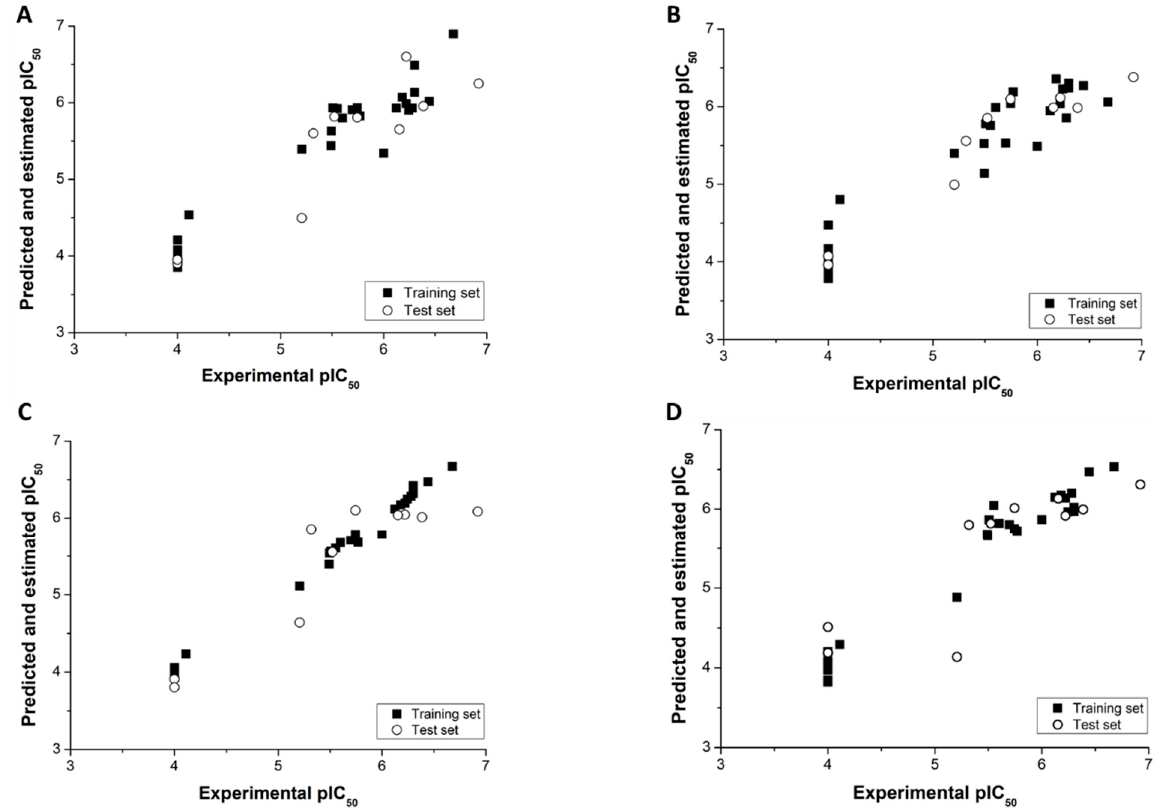
Figure 3. Experimental and predicted pIC 50 for the final QSAR models. ( A ) HQSAR; ( B ) AutoQSAR; ( C ) CoMFA; and ( D ) CoMSIA. Solid squares represent the training set, and open circles represent the test set.